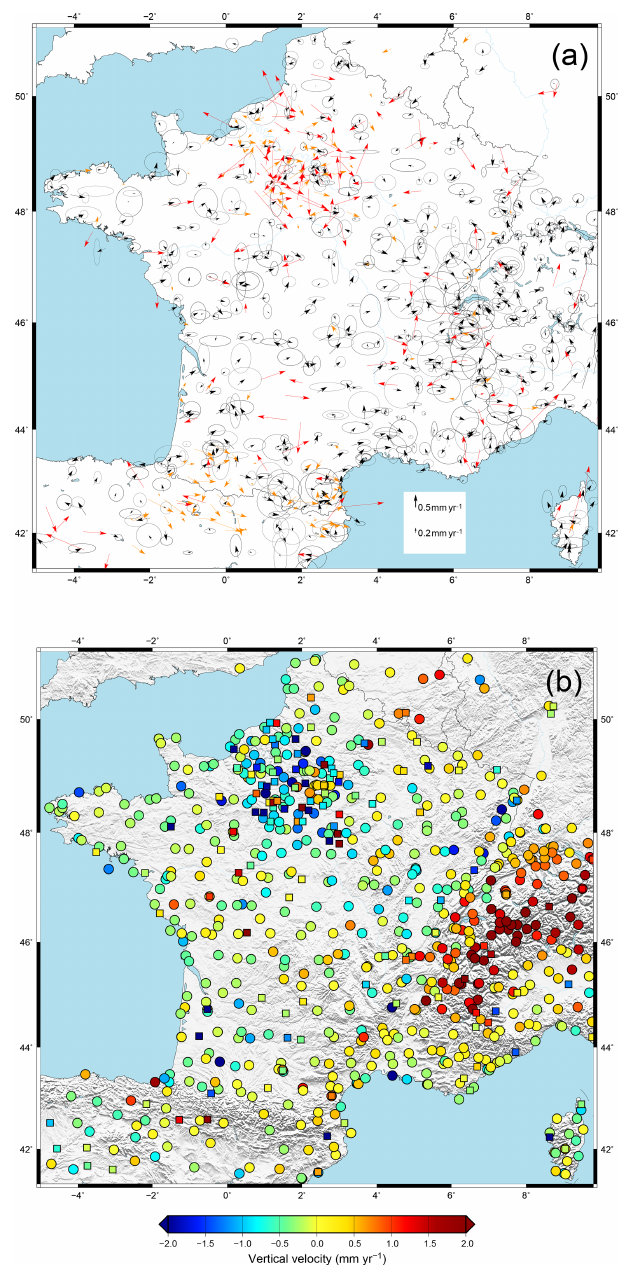
Figure 3. (a) Horizontal velocities for permanent and campaign sta- tions in France-centered reference frame. Black indicates the hori- zontal velocities associated with their 95% uncertainties, orange the horizontal velocities whose uncertainty is larger than 0.3mmyr − 1 for which the uncertainties are not represented for graphic reasons, and red the horizontal velocities of the stations identified as outliers and (b) vertical velocities; the squares correspond to the outliers, whose identification was made from the horizontal